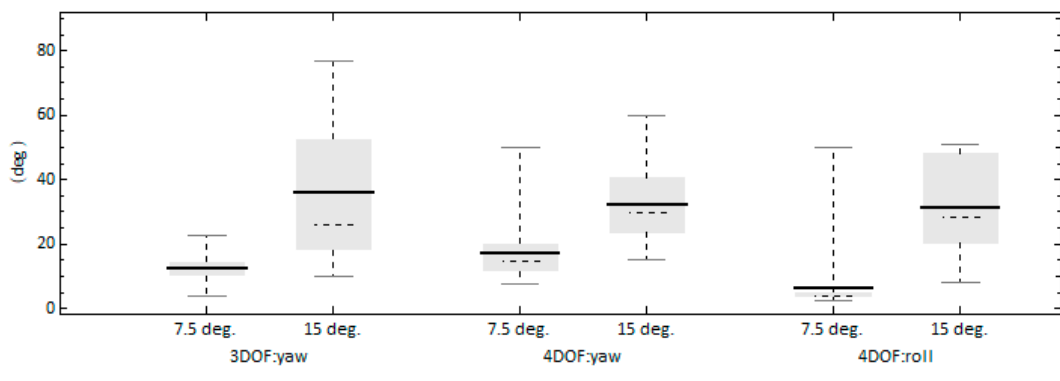
Figure 11. Effect of the commanded heading on the maximum yaw and roll angle achieved. For the 4DOF model, KG = 6.5 m.